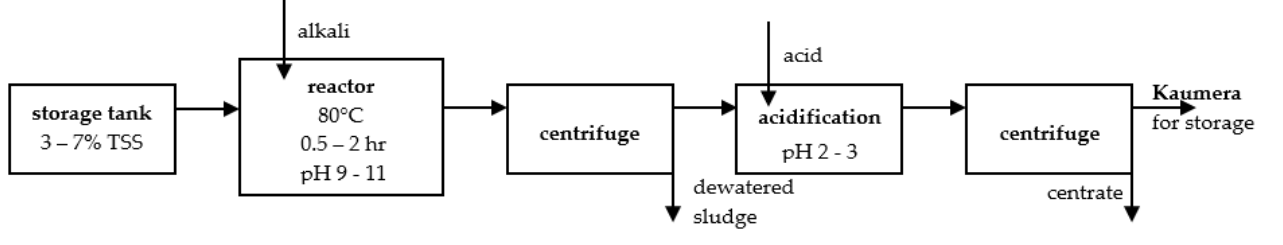
Figure 1. Kaumera Gum recovery process [44].